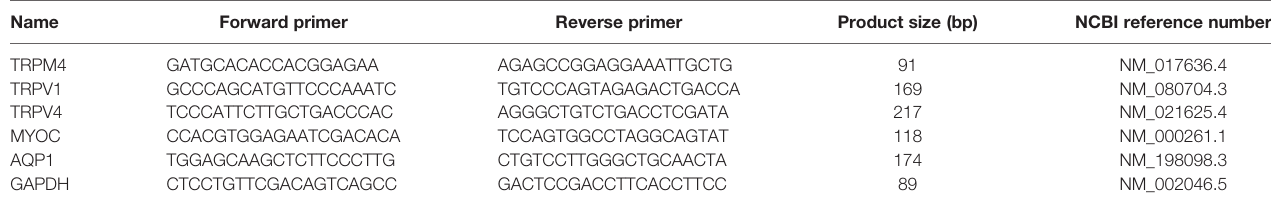
TABLE 1 | Primer sequences used for PCR